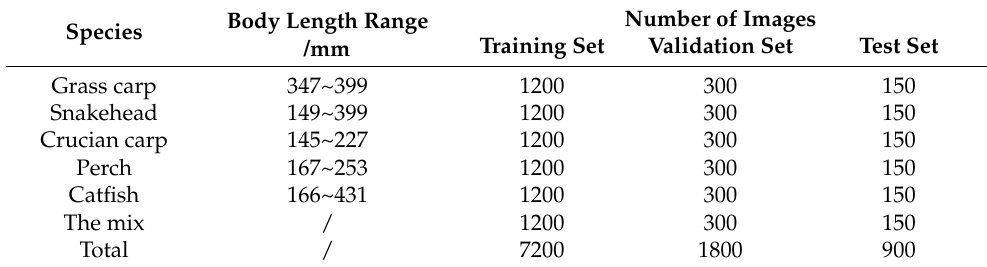
Table 1. Detailed information about the dataset.